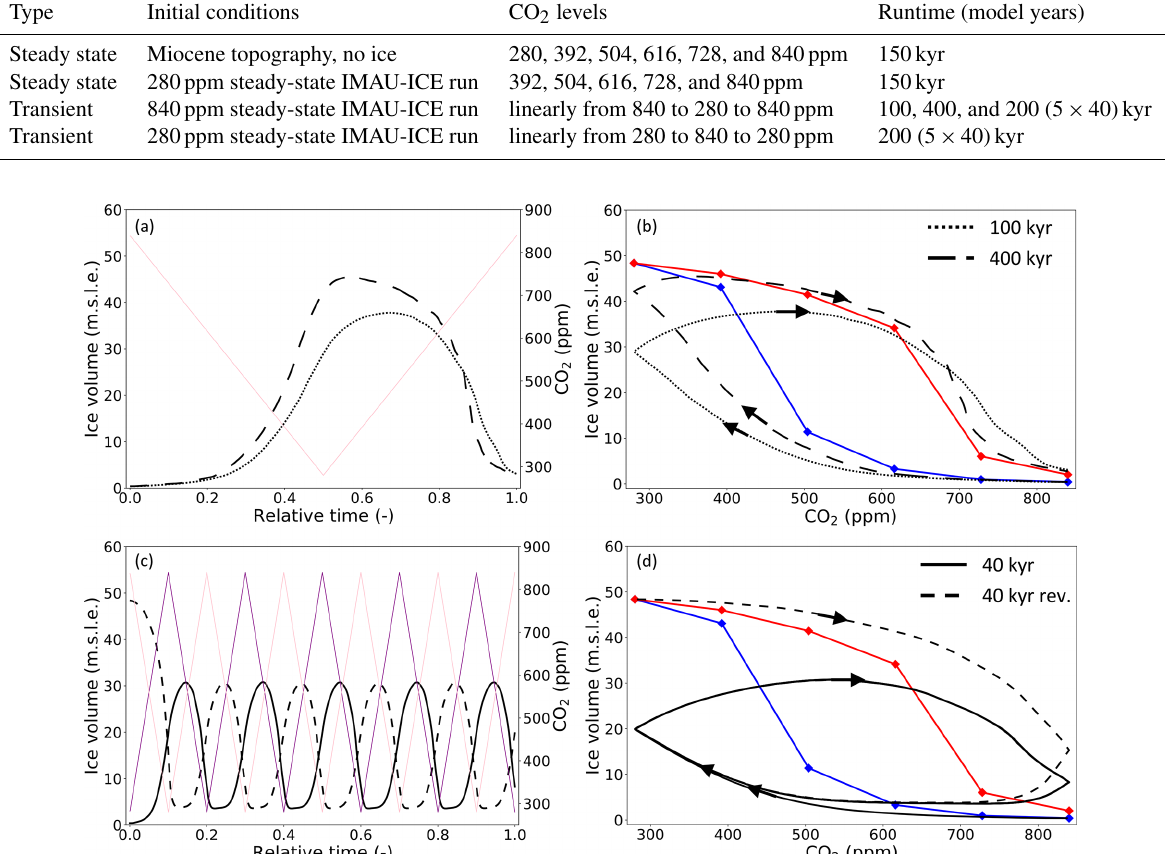
Figure 1. (a) Evolution of forcing CO 2 levels (pink) and ice volume above flotation (in metres sea level equivalent; black) over time (relative to the length of the simulation) for the transient 100kyr (dotted) and 400kyr (long-dashed) REF simulations. (b) Relation between CO 2 and equilibrium ice volume (ascending branch, blue; descending branch, red) and transient ice volume (black as in a ). (c, d) Same for the transient 40kyr simulations starting from warm (CO 2 pink, ice volume solid black) and cold (CO 2 purple, ice volume dashed black) conditions. Arrows in (b) and (d) indicate the progression direction of ice volume. In (d) , the transient ice volume evolutions of both simulations partly overlap.